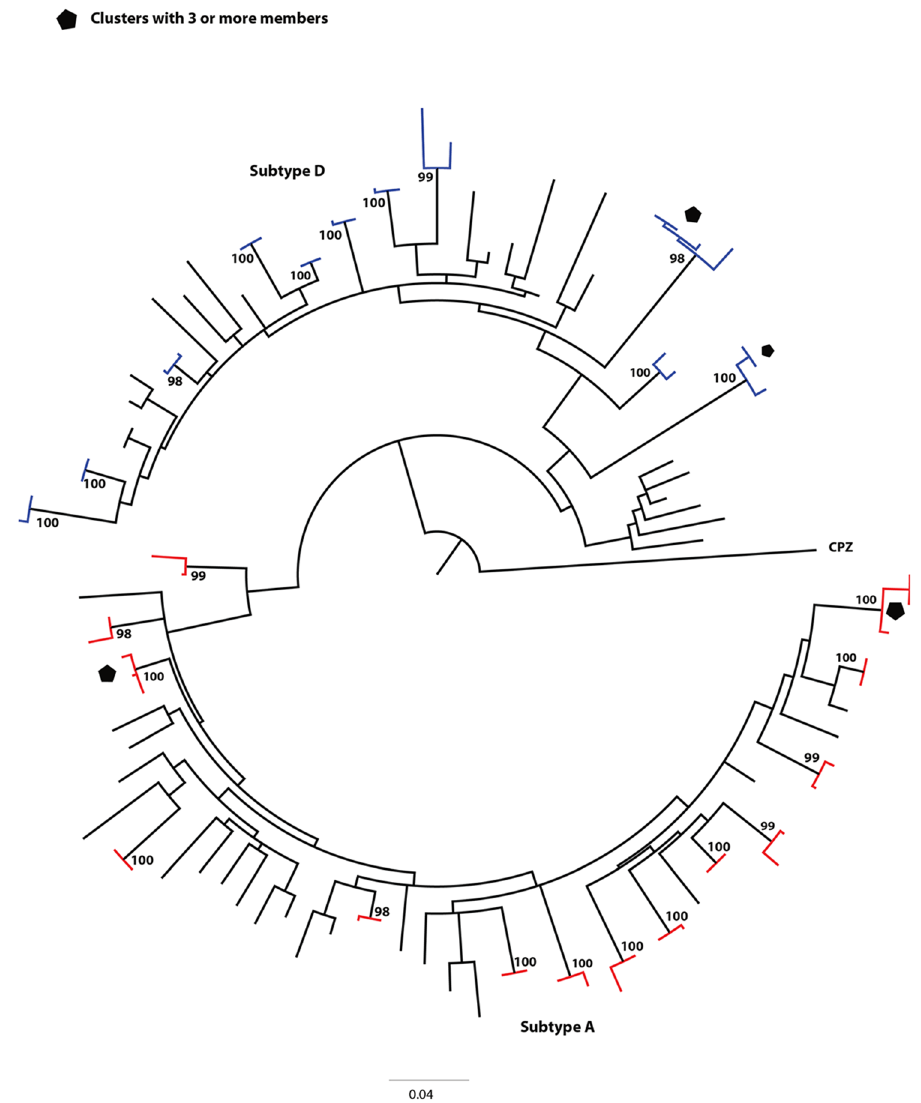
Fig 4. Maximum-likelihood phylogenetic tree showing the HIV transmission clusters in env gene approximately 460 base pairs (n = 22) involving 79 of the 266 participant sequences shown while the rest of clusters had two members. One cluster with bootstrapof 99% and geneticdistanceof (cid:20) 4.5% is includedsince it clusteredin gag . Subtype A clusters are highlightedred, subtype C purple and subtype D blue. The tree scale is